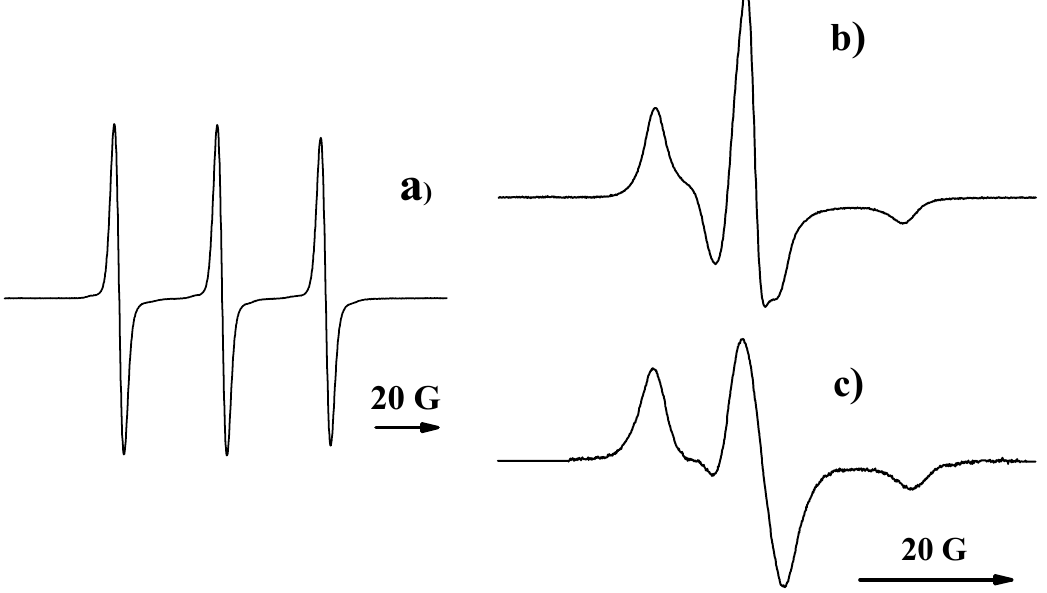
Figure 5. EPR spectra of TEMPOL in PBS at 298 K ( a ) and in PDL 02 at 298 K ( b ) and 100 K ( c ).